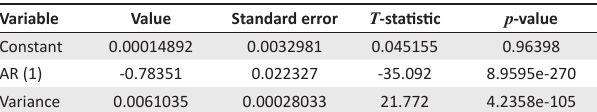
4. Modelling Nikkei 225 estimating autoregressive integrated moving average and generalised autoregressive conditional heteroscedasticity for the best possible fit of the respective